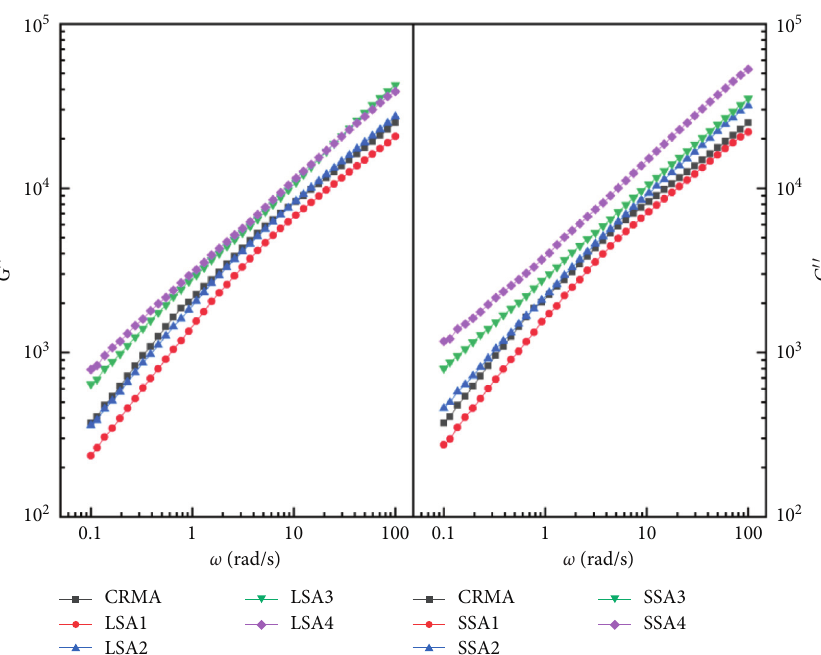
Figure 12: Variation of G ″ with the SBS contents for modified